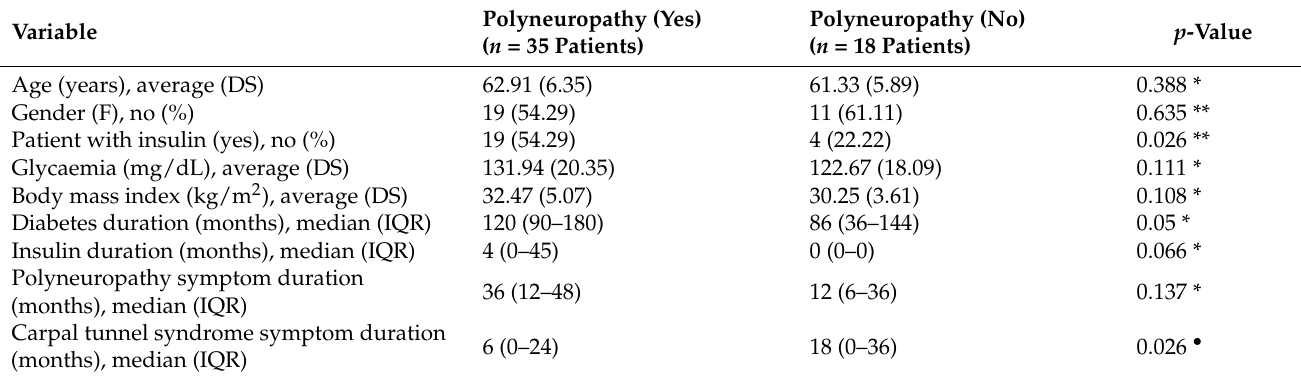
Table 1. Demographic data and clinical distribution of patients with and without diabetic